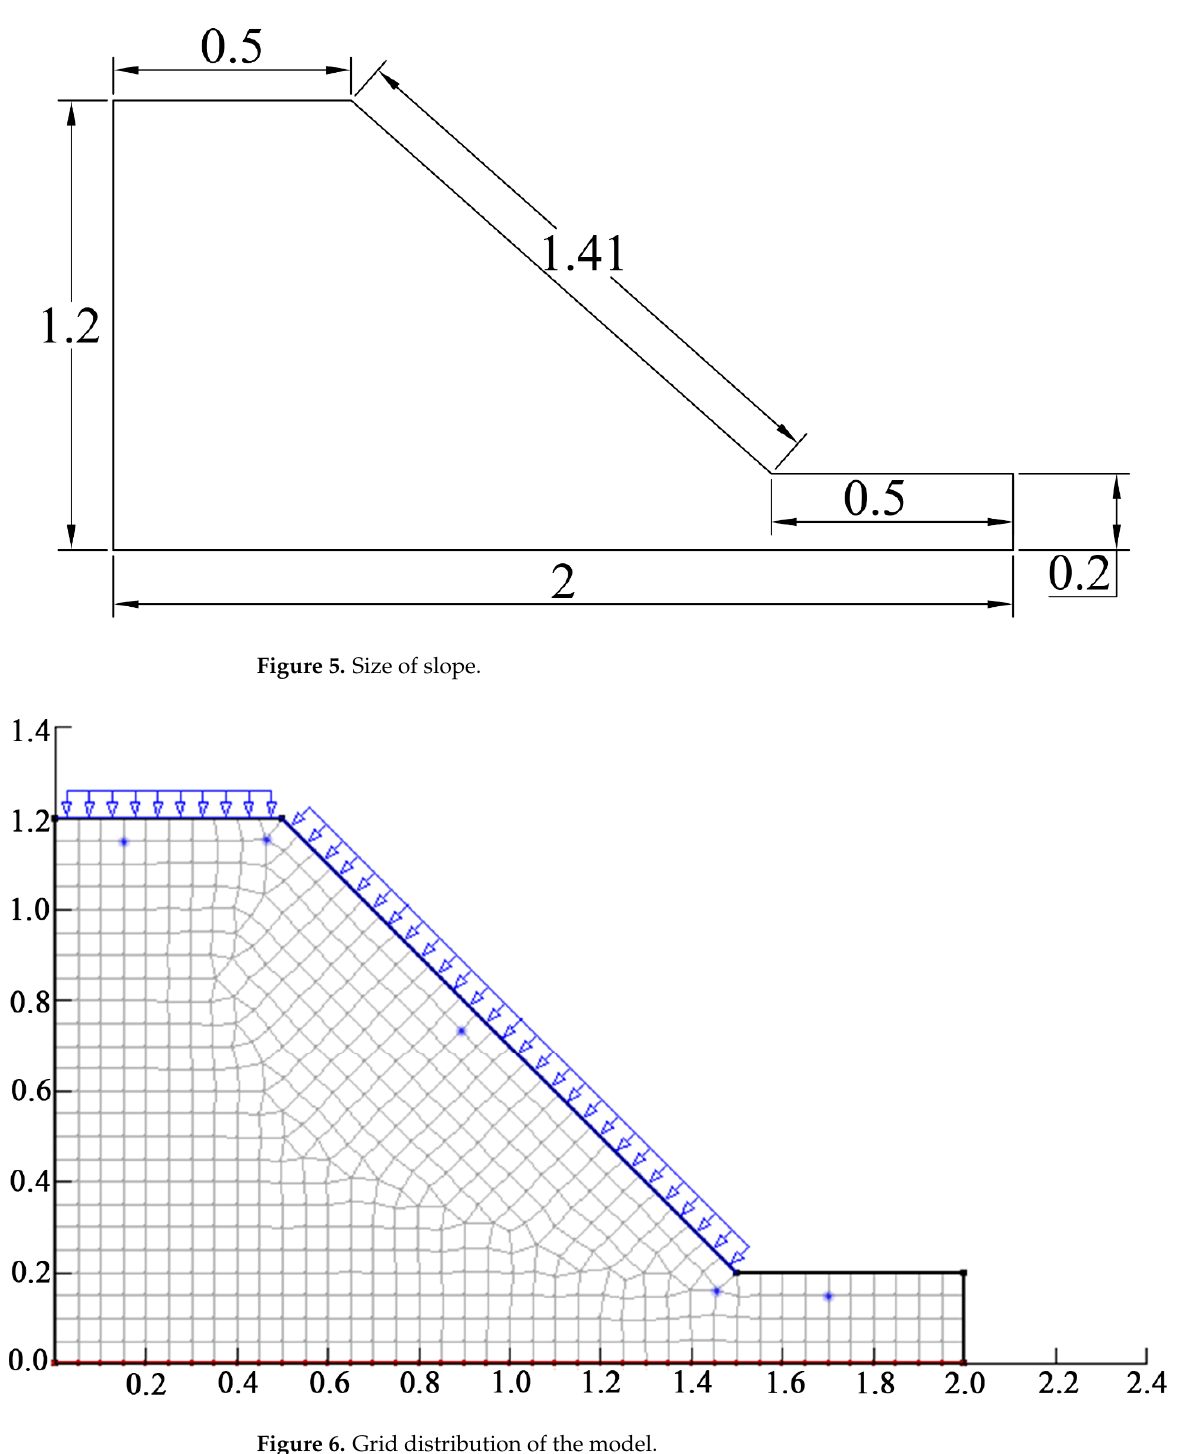
Figure 6. Grid distribution of the model.